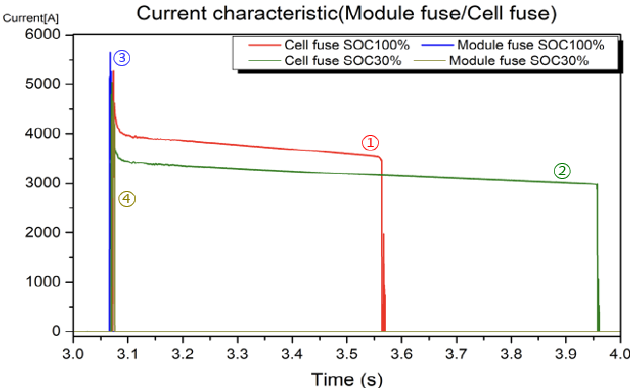
Figure 10. Current status of battery module during external short-circuit test.